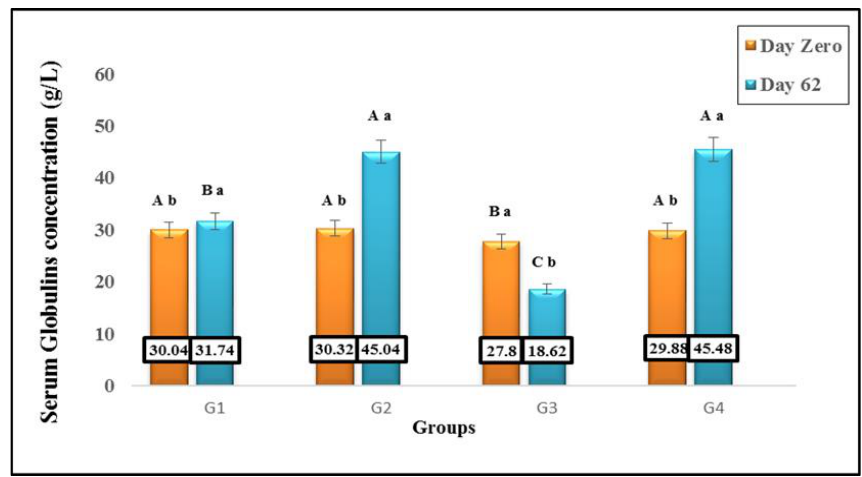
Figure 10. Effect of Phosphatidylcholine, Fructose and/or their combination on serum globulin Concentrations (g/L). Mean ± SE, n = 9 in a group. G1 control groups (C), G2: (Pc), G3: (Fr), G4: (Fr + Pc). A-C Significant variations P≤0.05 between